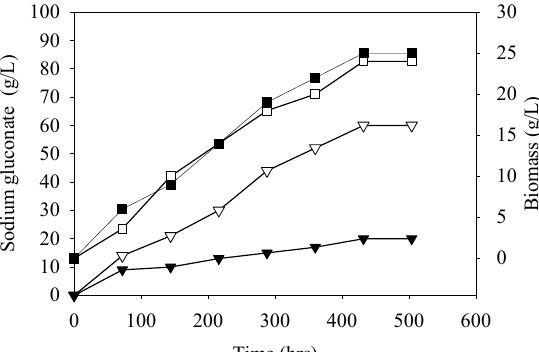
Figure 1. A typical time course of sodium gluconate fermentation. Symbols represent: (∆) Sodium gluconate from A.niger UV-112; (▼) Sodium gluconate from A.niger RP-11; (□) cell concentration of A.niger UV-112 and ( ) cell concentration of A.niger ▀